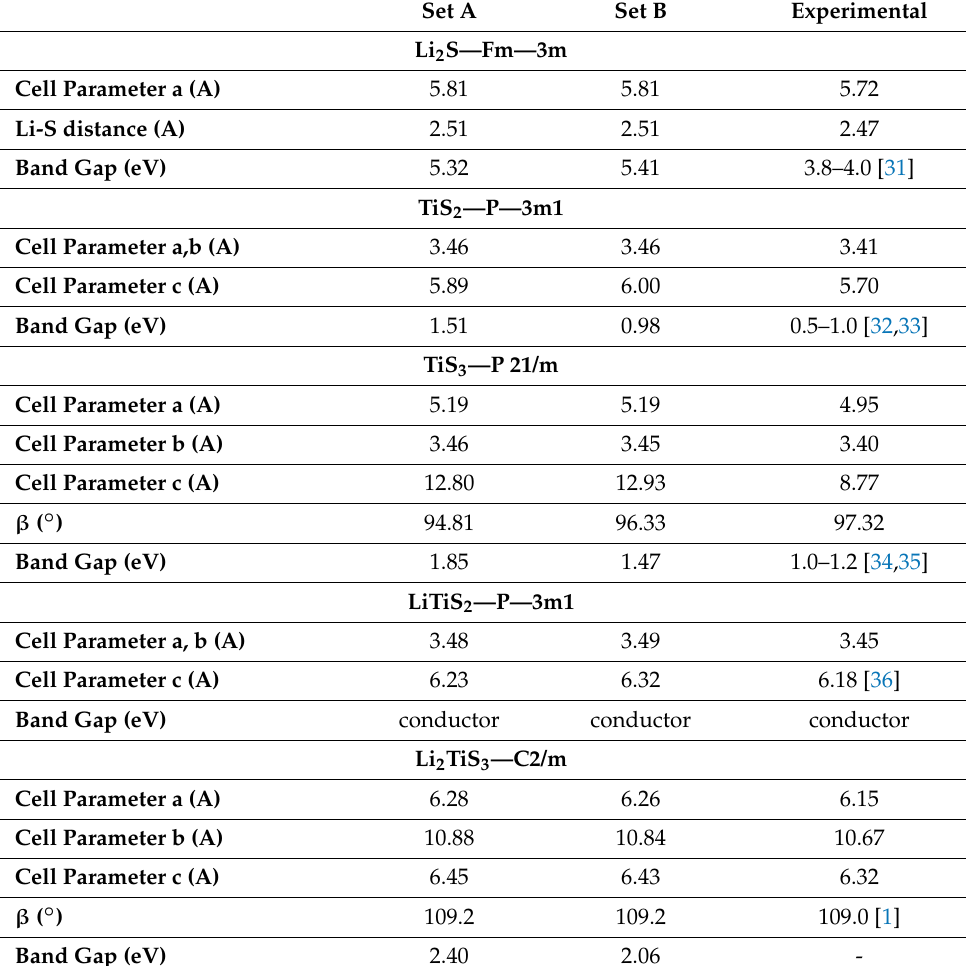
Table 1. Structural parameters and band gap for Li 2 S, TiS 2 , TiS 3 , LiTiS 2 , and monoclinic Li 2 TiS 3 . Experimental structural data are retrieved from ICSD, band gap from the reference indicated in the table. Set A Set